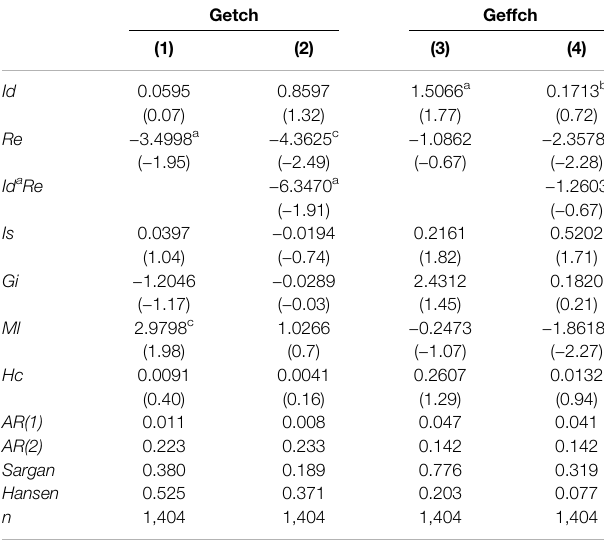
Table 6 re fl ects the estimated results of models 1 and 3 after replacing the explained variable. From the estimated parameters of the model, the p values of AR (1) were all less than 0.05 and those of AR (2) were all greater than 0.05.